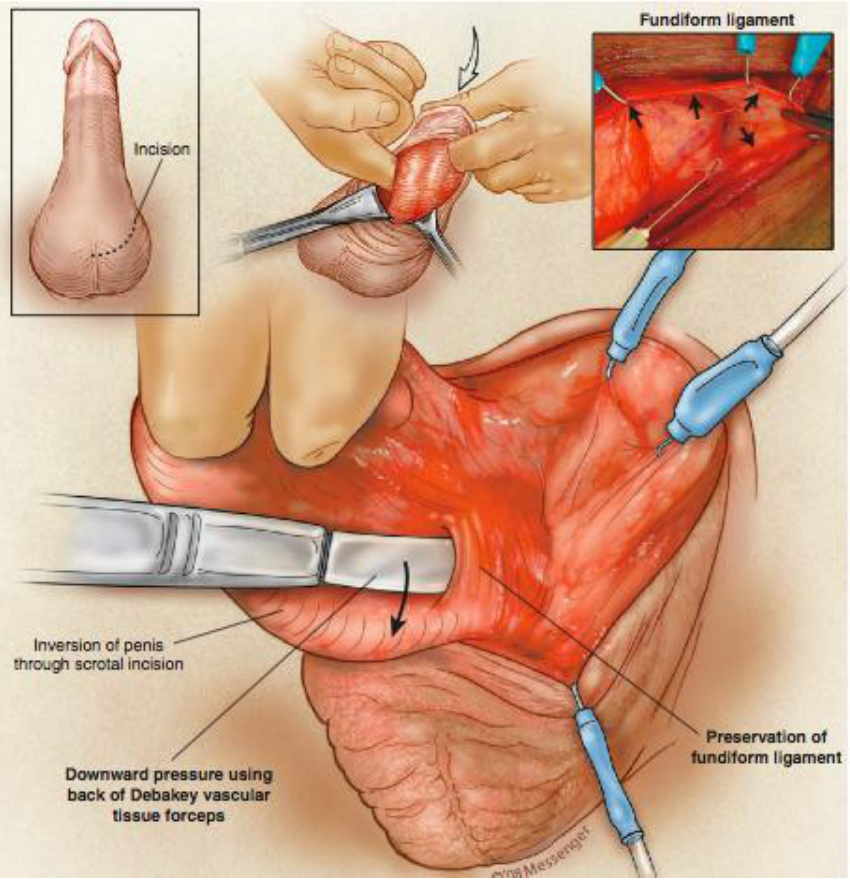
FIGURE 1. Dorsal artery dissection. (From Goldstein, I., Bastuba, M., Lurie, A., and Lubisich, J. [2008] Penile revascularization. J. Sex. Med. 5(9), 2018-2021. With permission.)